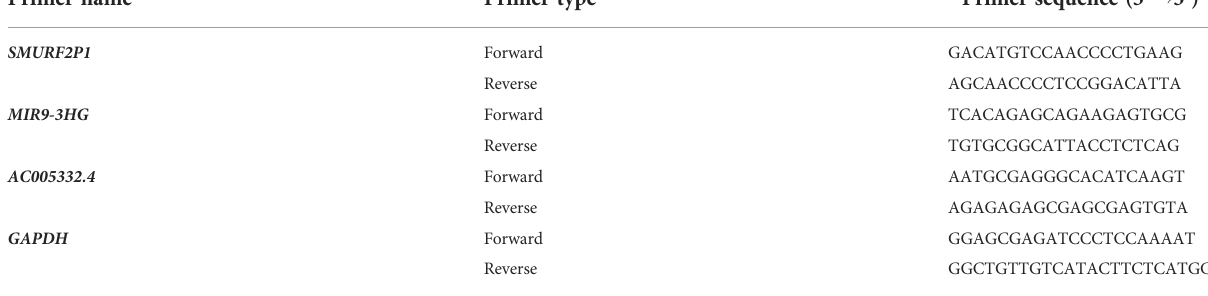
TABLE 1 PCR primers used in this